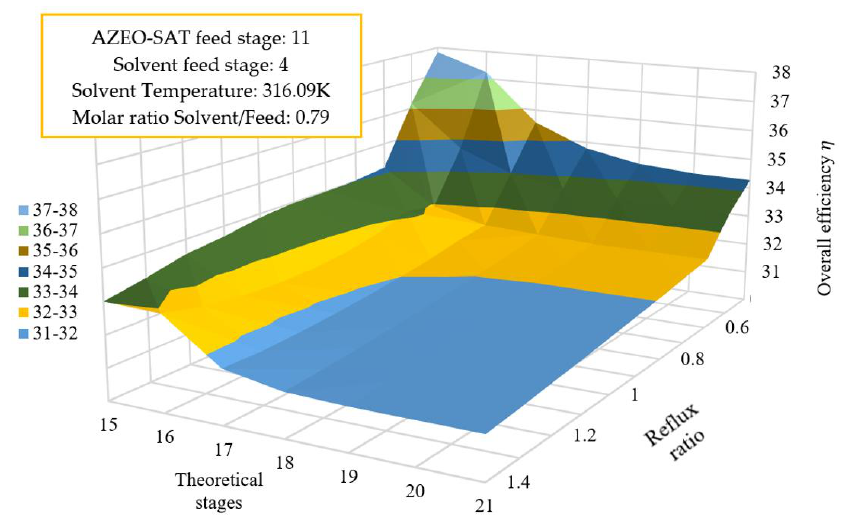
Figure 3. Variation of the reflux ratio and number of theoretical stages on the overall efficiency of the process.